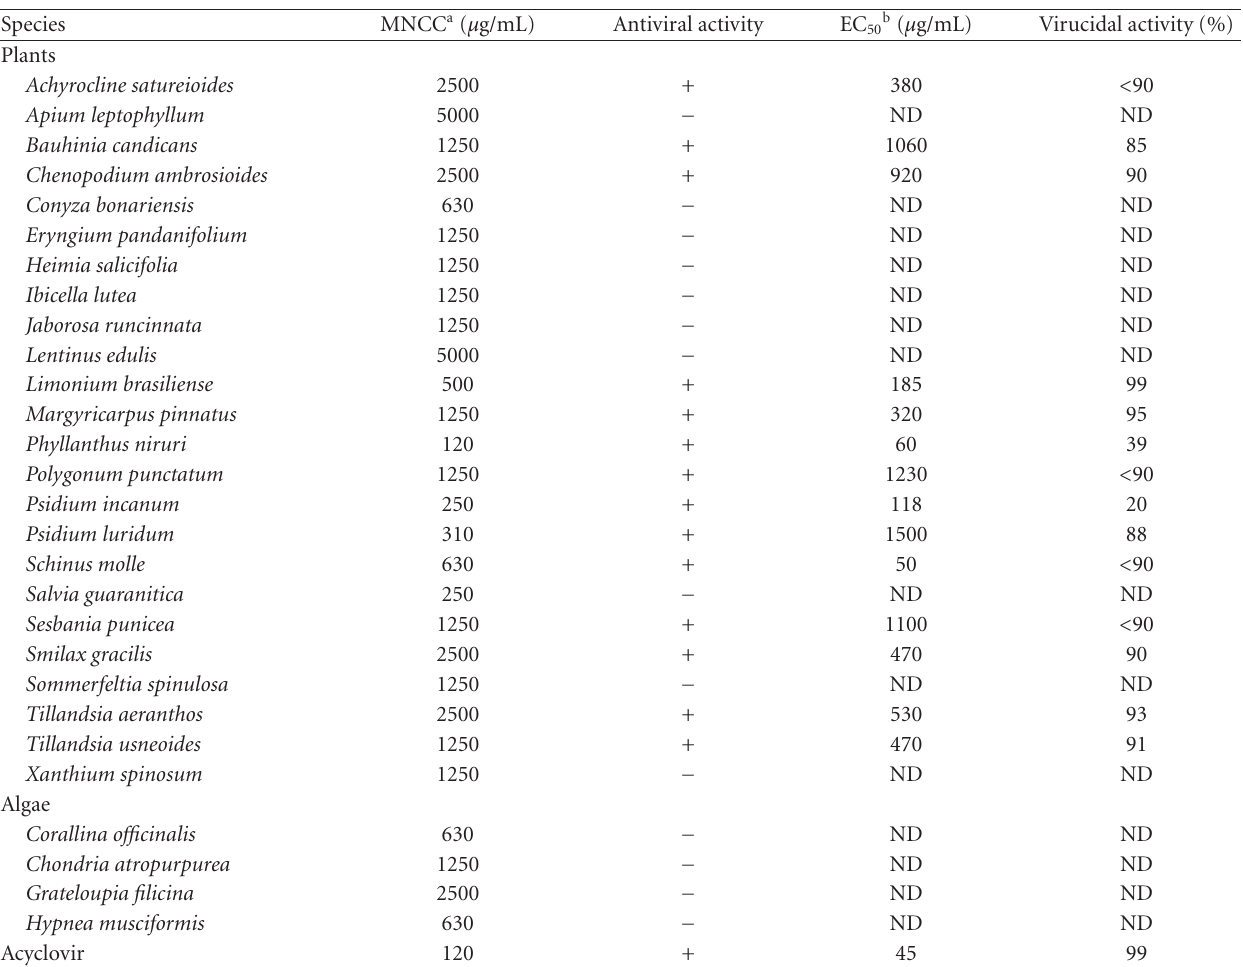
Table 1: Antiviral and virucidal activity of each plant and algae species.